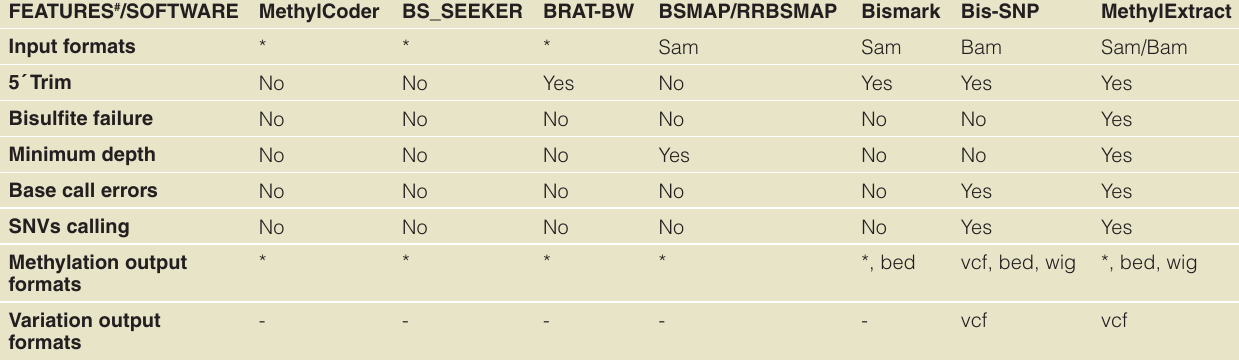
Table 1. Comparison of MethylExtract with different programs for methylation profiling and SNV